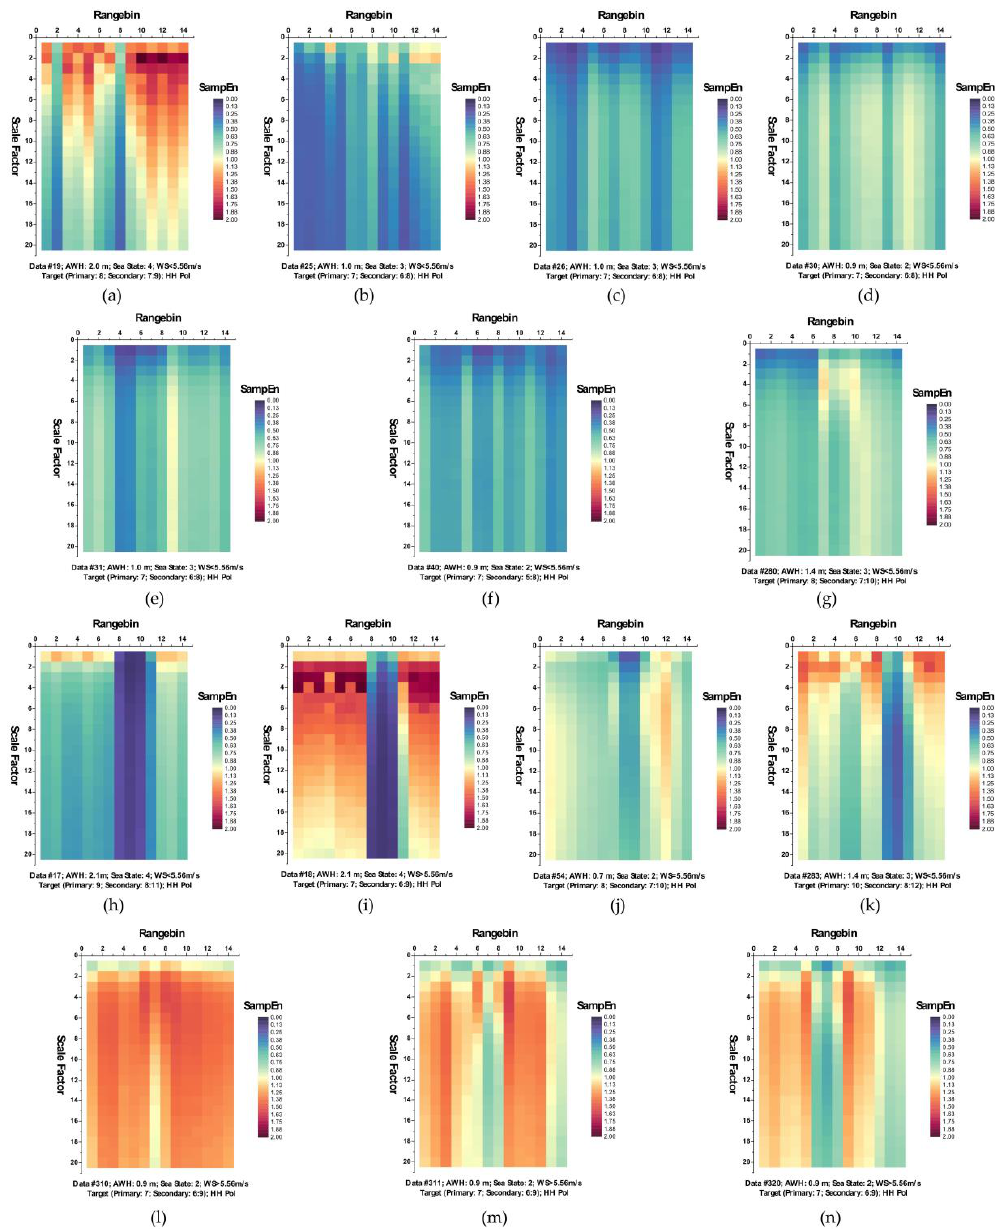
Figure 6. ( a – n ) MSE of 14 sea clutter data sets (HH polarization, m = 2, τ = 20, r = 0.15 ∗ std { s }